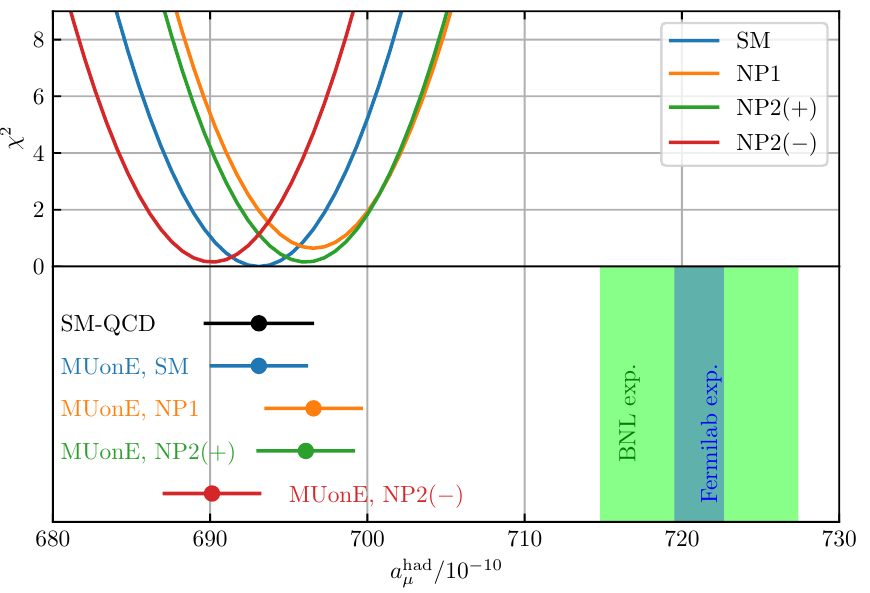
Figure 5 . Impact of NP on the MUonE measurement of a had . Here NP1 and NP2 are two (cid:22) benchmark scenarios of the t -channel Z 0 model marked in (cid:12)gure 4, and the parameters are given in eq. (3.4). The upper part show the (cid:31) 2 -curves for the SM, NP1 and NP2( ), while the 1 (cid:27) ranges of (cid:6) the SM QCD prediction of a had , the MUonE sensitivity in the SM, NP1 and NP2( ) are presented (cid:22) (cid:6) in the lower part. Also shown are the value of a had from current BNL experimental value of g 2 (cid:22) (cid:0) (green) [1] and future prospect at Fermilab (blue)